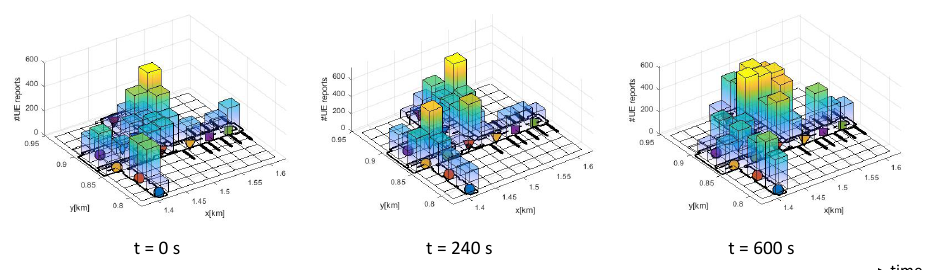
Figure 5. Evolution in the number of received User Equipment (UE) reports (#UE reports) for different classification epochs (60